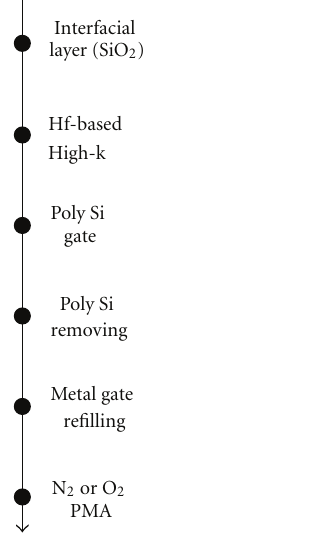
Figure 1: The fabrication process of the high-k metal gate last device.